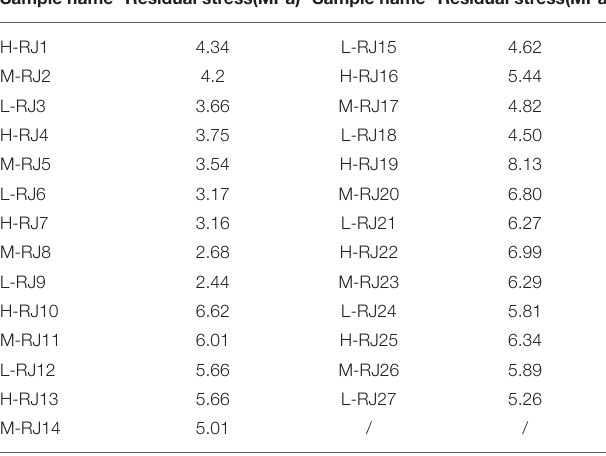
TABLE 4 | Residual shear stress used to verify the feasibility of the proposed model.